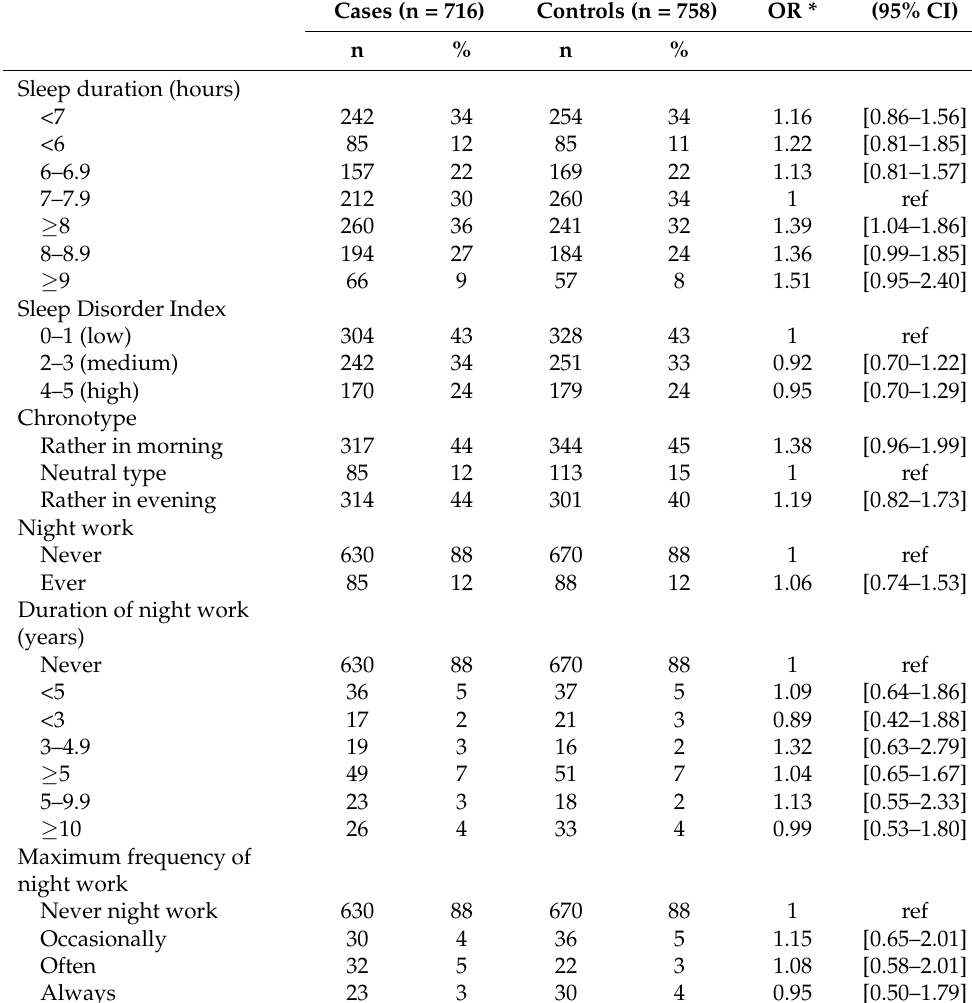
Table 2. Association between sleep traits, chronotype and night work characteristics and lung